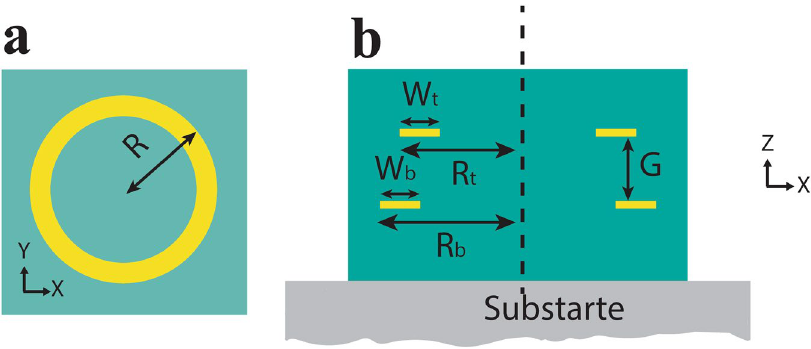
Figure 6. ( a ) Single ring (front view). ( b ) Single unit of double stacked rings (side